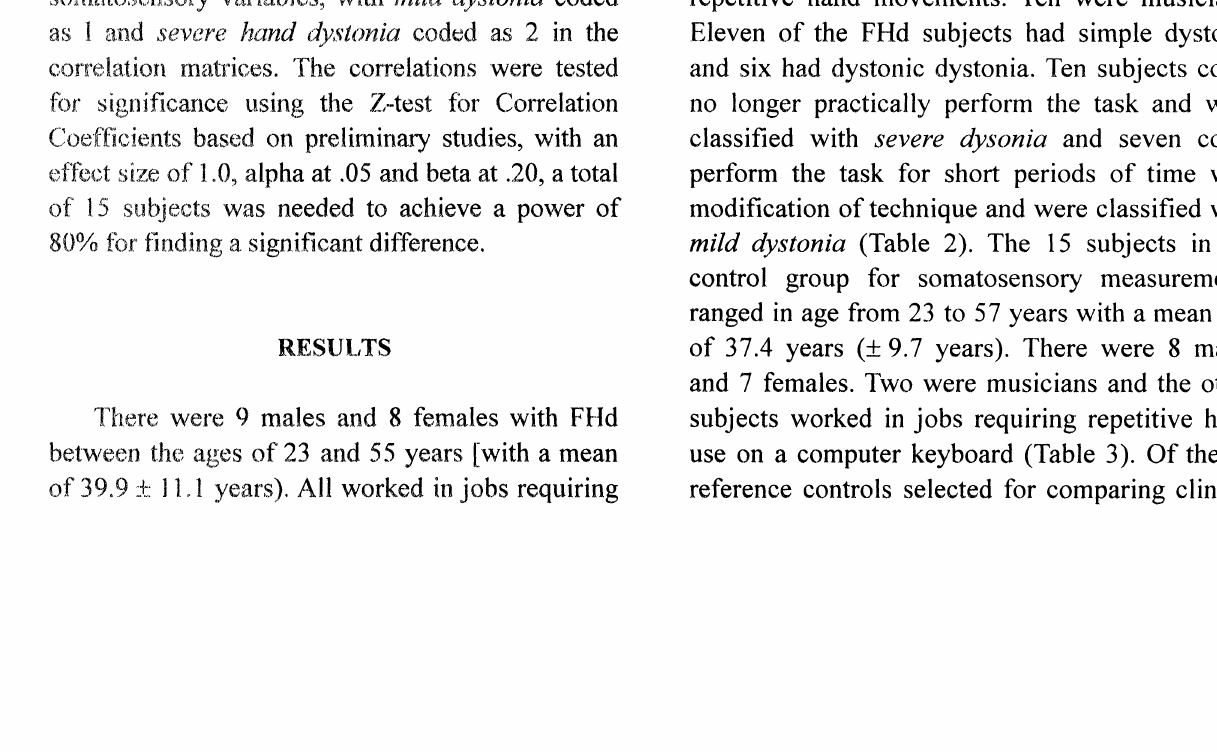
Fig. 1: Latency and amplitude of somatosensory evoked field response (SEF).by stimulus force. Controls and subjects with mild versus severe Fltd. There were no consistent differences in the latency or the amplitude of the somatosensory evoked response between 5 and 20 psi for the healthy control subjects (4 subjects, 3 trials, 3 digits) or those with focal hand dystonia (2 subjects, 3 trials, 3 digits). The amplitude did increase slightly whe, the stimulus force was increased to 25